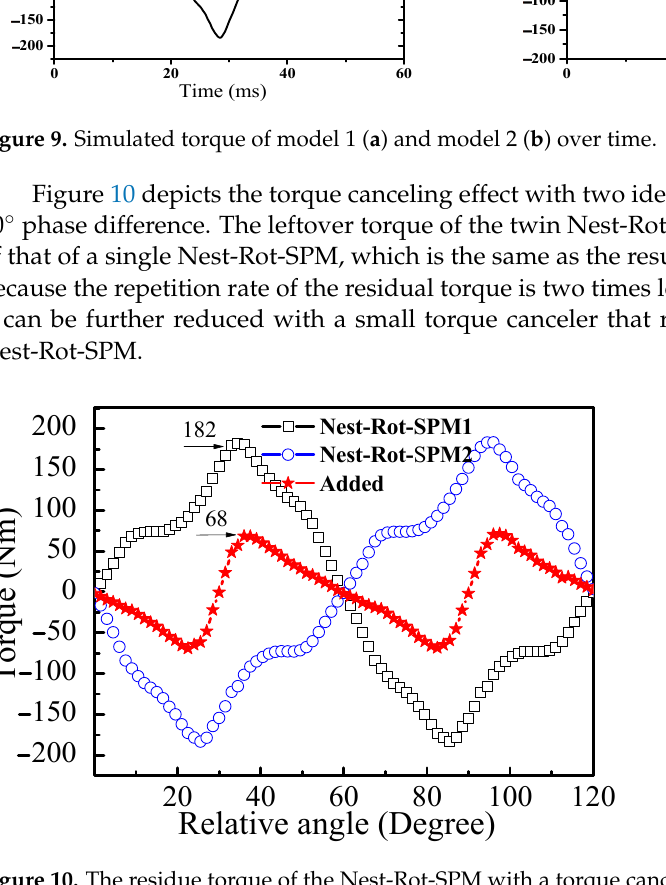
Figure 10. The residue torque of the Nest-Rot-SPM with a torque canceler.